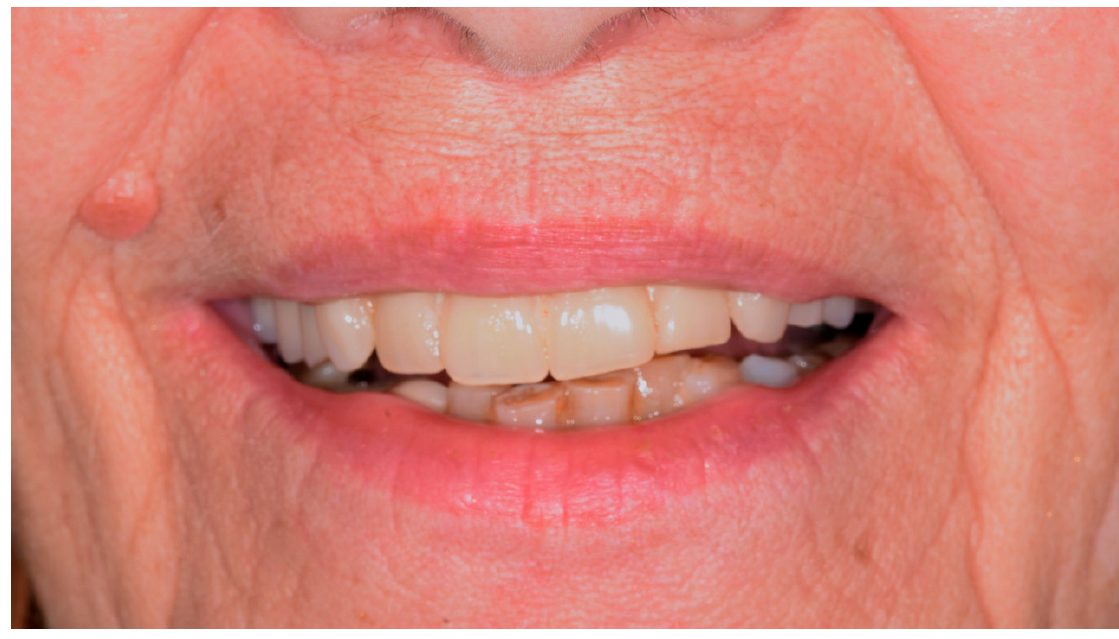
Figure 1. Initial photo of the patient with the old prosthesis.